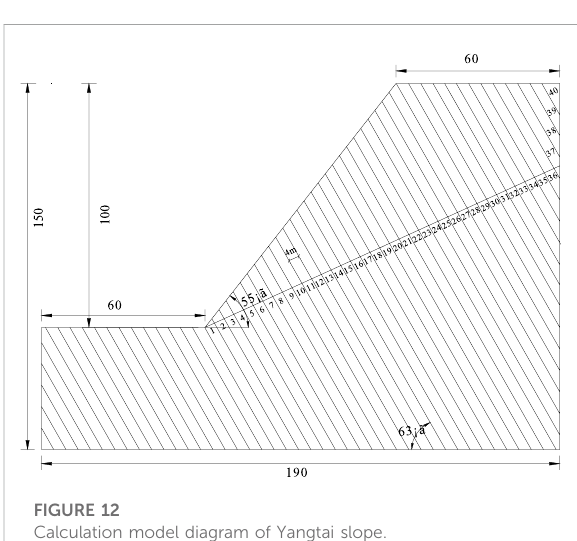
FIGURE 12 Calculation model diagram of Yangtai slope.